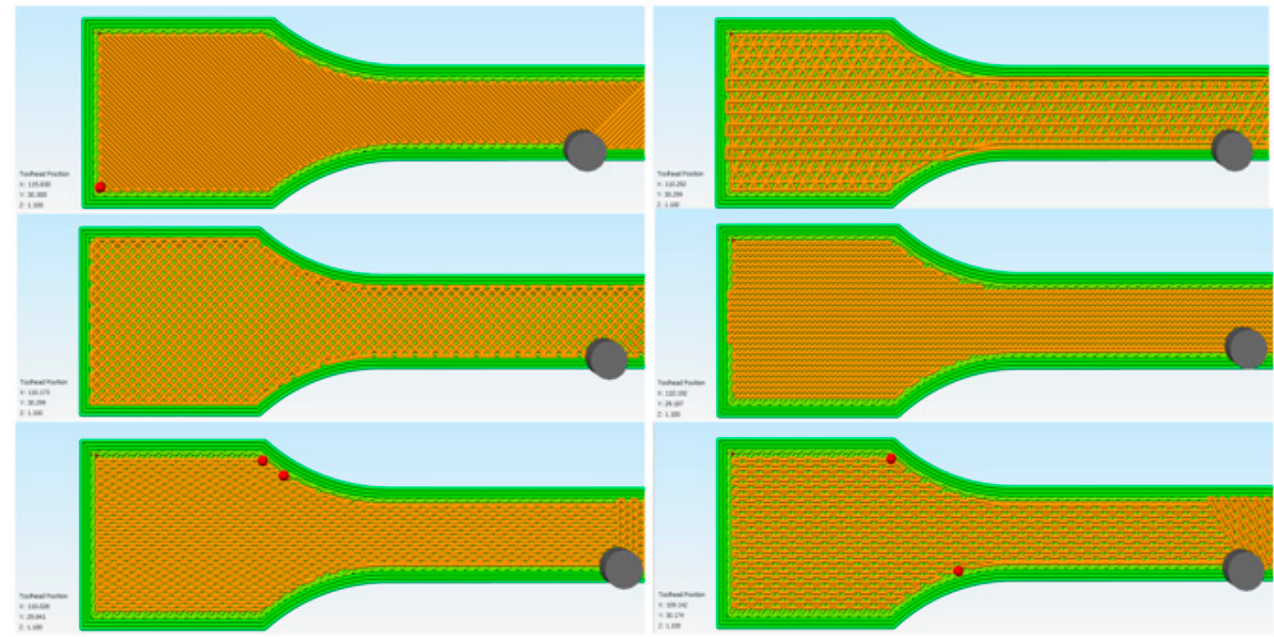
Figure 6. Differences in the applied infill strategy.